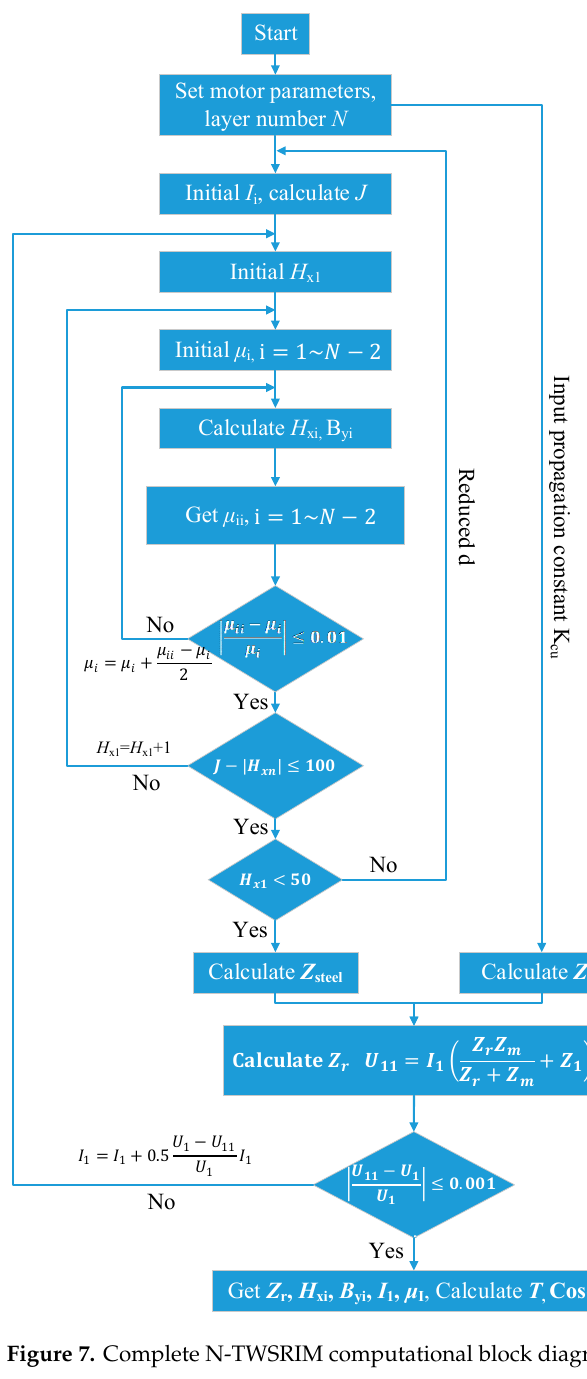
Figure 7. Complete N-TWSRIM computational block diagram. Table 3. Equivalent circuit parameters of non-copper and copper plating models (slip = 1).